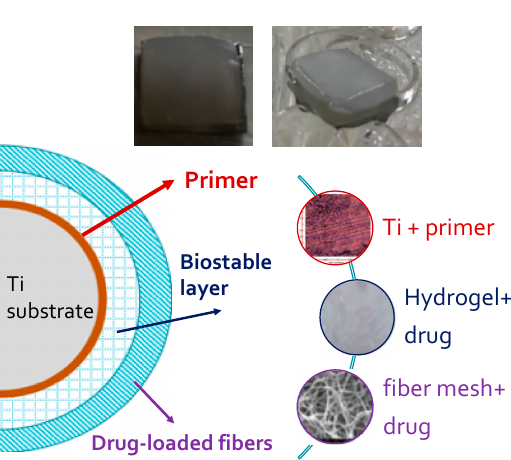
Figure 11. Photos of multifunctional coating onto Ti substrate before and after immersion in incubation medium; schematic representation of final assembly of composite coating.